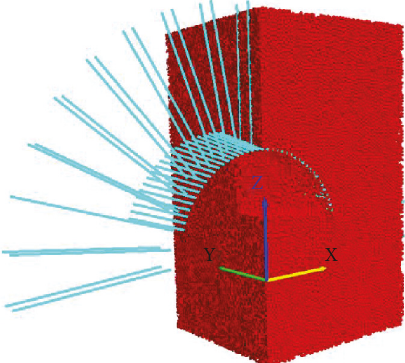
Figure 15: Calculation model of combination support with small pipes and